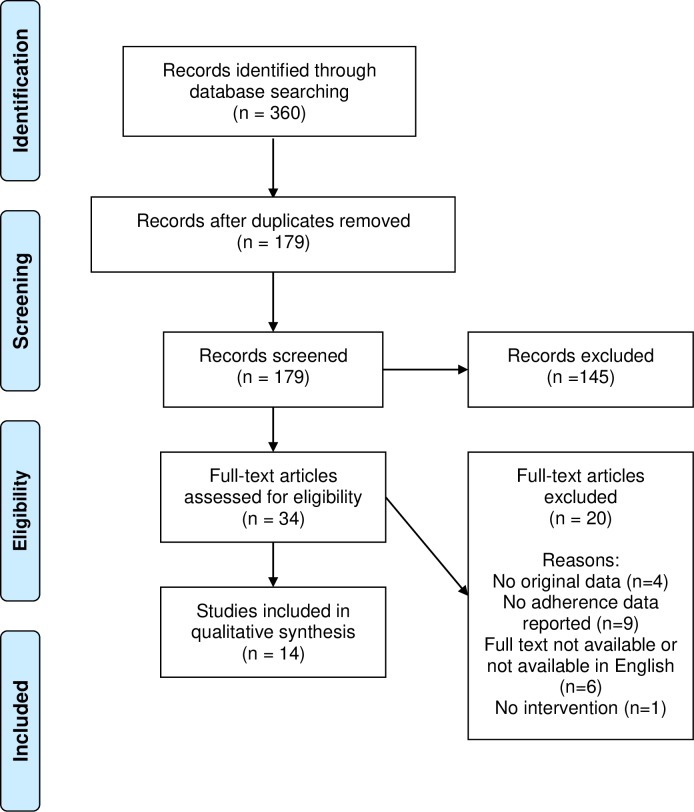
PRISMA flow diagram.